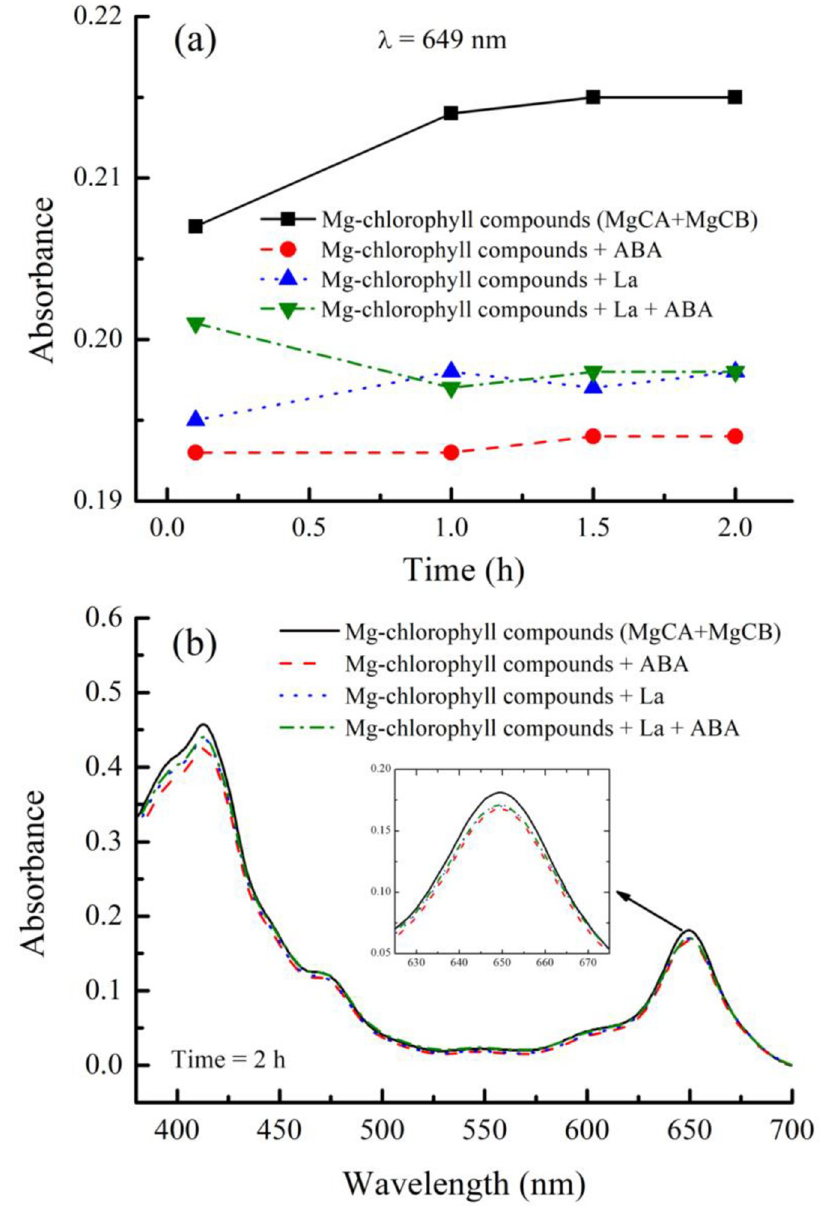
(MgCA+MgCB), ABA, La, and La + ABA